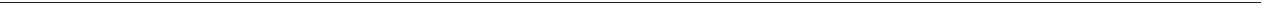
Fig. 5 USP52 promotes chromatin assembly through stabilizing ASF1A. a MNase digestion assay. Control HeLa cells or HeLa cells stably expressing the indicated genes were transfected with the indicated siRNAs and synchronized by nocodazole followed by drug removal and FACS analysis at 2 h interval. Cell cycle pro fi les after synchronization and release into speci fi c cell cycle stages are shown in Supplementary Fig. 5a. The same amounts of isolated nuclei from S-phase cells were treated with MNase (0.4 gel Unit/ μ l) and puri fi ed DNAs were resolved in 1.5% agarose gels followed by EtBr staining. The MNase digestion patterns were quanti fi ed by densitometry and the positions of mono-, di-, and tri-nucleosomal DNA fragment are indicated. In panel 2, cells with Dox-inducible expression of ASF1A were transfected with control siRNA or USP52 siRNA in the presence or absence of doxycycline. b Cellular lysates from cells in a were analyzed by western blotting with antibodies against the indicated proteins. c Immuno fl uorescence analysis of HeLa cells transfected with control siRNA, USP52 siRNA, or ASF1A siRNA followed by EdU pulse labeling. PCNA staining served as a marker for S-phase cells. Scale bar, 10 μ m. Percentage of EdU or PCNA-positive cells with both strong and weak stainings was counted. Each bar represents the mean ± S.D. for biological triplicate experiments. The distribution of EdU or PCNA intensities from more than 200 cells is presented as dot plotting. ** P < 0.01, one-way ANOVA. d HeLa cells stably expressing FLAG-ASF1A or FLAG-USP52 were transfected with control siRNA, USP52 siRNA, or ASF1A siRNA as indicated and analyzed by immuno fl uorescence after EdU pulse labeling. Scale bar, 10 μ m. Percentage of EdU-positive cells with both strong and weak stainings was counted. Each bar represents the mean ± S.D. for biological triplicate experiments. The distribution of EdU intensities from almost 200 cells is presented as dot plotting. ** P < 0.01, one-way ANOVA. e Control cells or HeLa cells stably expressing FLAG-ASF1A were transfected with indicated siRNAs and cell cycle pro fi les were analyzed by FACS. Cellular lysates from these cells were analyzed by western blotting with antibodies against the indicated